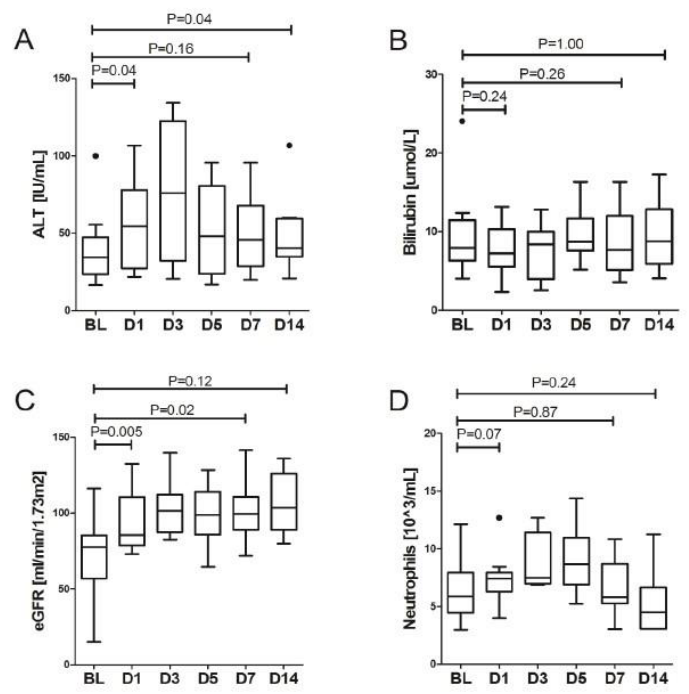
Figure 2. The change in concentration of selected parameters in the blood in subsequent days after LDRT: ( A ) alanin aminotransferaz, ( B ) bilirubin, ( C ) glomelural filtration, ( D ) neutrophils level. Bold dots denote outliers.